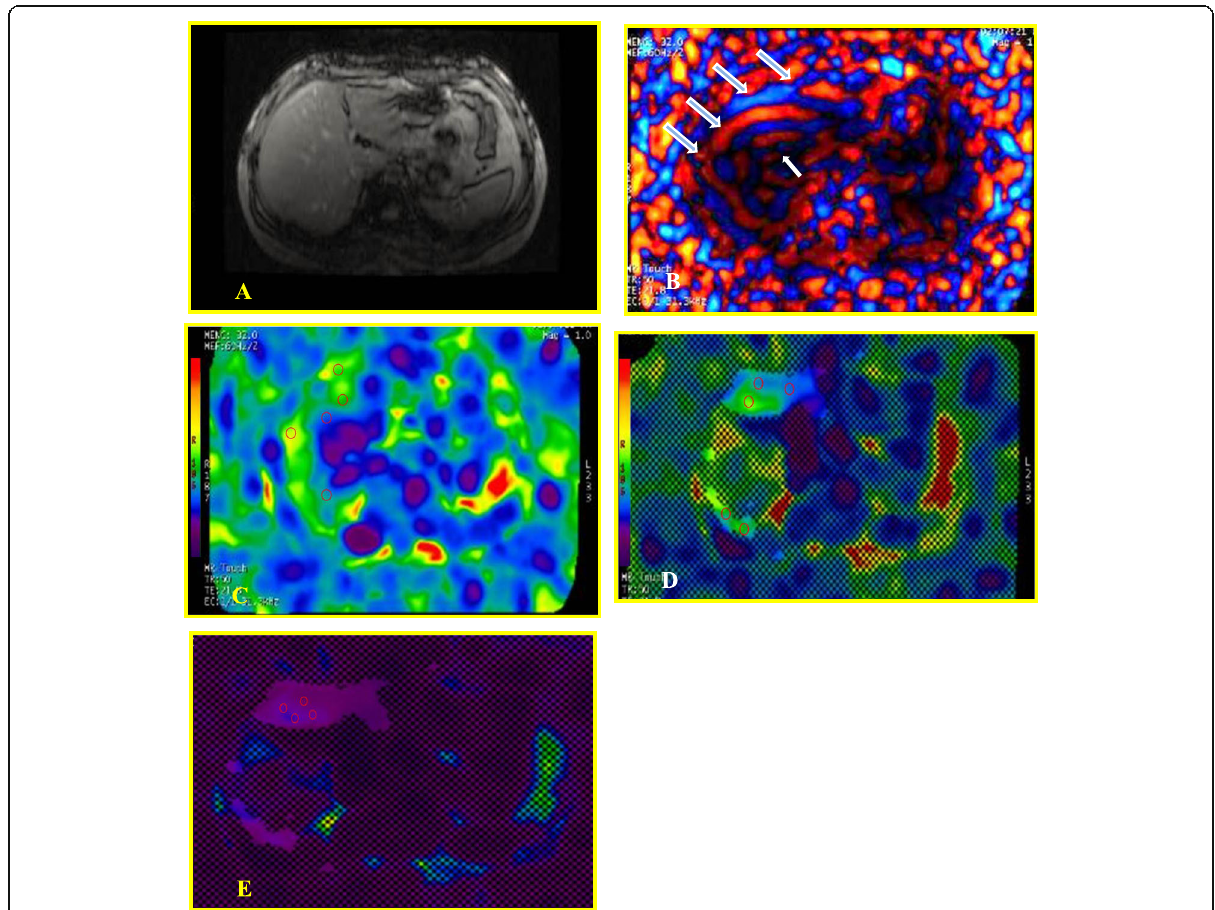
Fig. 5 a – e Demonstrates MRE sequence images of a 40-year-old LLD candidate with mild hepatic fibrosis of F1 stage, according to METAVIR score of fibrosis, and the estimated mean stiffness of the liver was 2.39 kPa. The obtained MRE sequence images include; the conventional anatomical reference image of MRE single slice ( a ) and the corresponding shear wave images ( b ), as well as the color-coded elastogram and associated confidence map with 0 – 8 kPa ( c and d , respectively), in addition to the color-coded confidence map image with 0 – 0 kPa ( e ). The conventional anatomical reference image ( a ) reveals apparently normal hepatic tissue, while the analysis of the corresponding color-coded shear wave image ( b ) show thick, wide, irregular, and longer wave length throughout the liver, particularly in the right hepatic lobe (the arrows in image b ). Moreover, the valid area for hepatic stiffness estimation in color-coded confidence map with 0 – 8 kPa ( d ) stained with light blue colour with associated area with light green color, while it displayed light blue colour with purple background on confidence map with 20 kPa ( e ). According to the corresponding color bars, these colors represent increased tissue stiffness with the mean estimated stiffness values of the liver in the ROIs, on confidence maps (red and yellow rings on c and d images, respectively) was 2.39 kPa (stiffness of stage F1 fibrosis). Moreover,